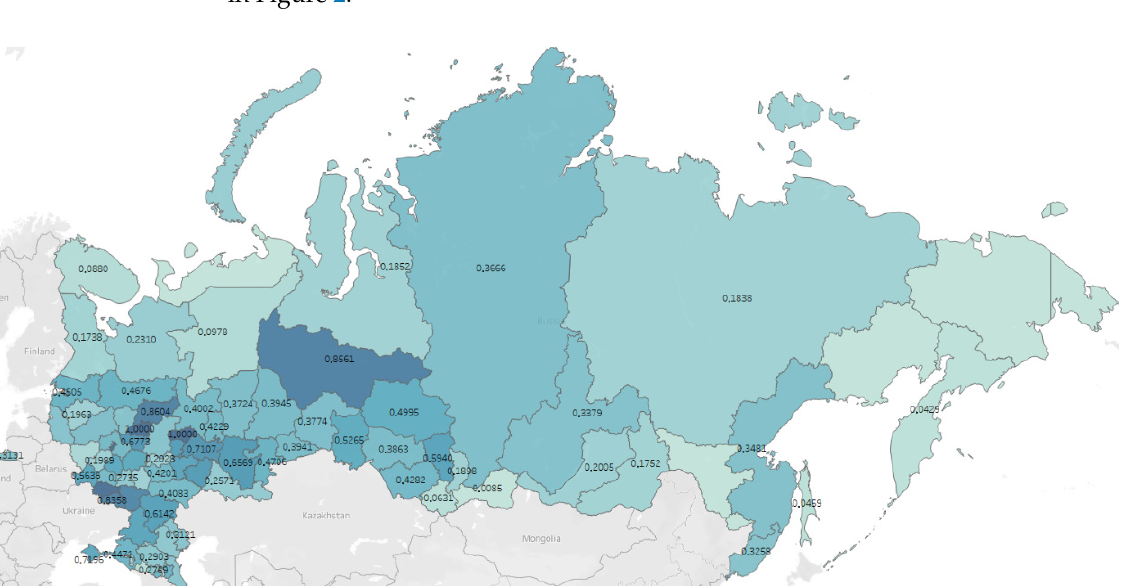
(1), Lipetsk Region (0.8833), Sakhalin Region (0.7629) and Yamalo-Nenets Autonomous Okrug